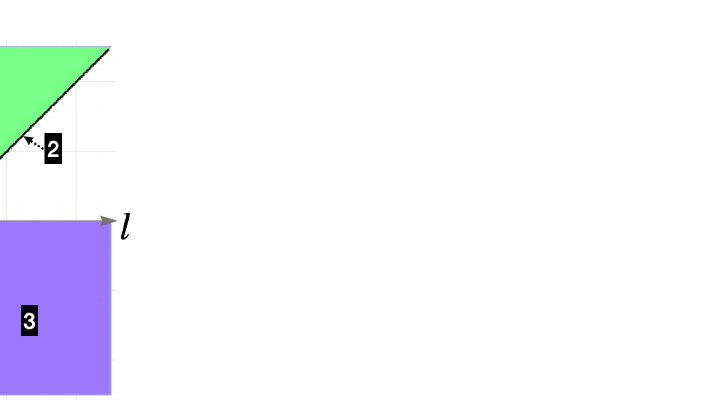
Figure 5. The numbered regions are derived from the conditions of Theorem 2 that ensures existence of NE for the repeated modification of generic game G 10 for possible values of l and g